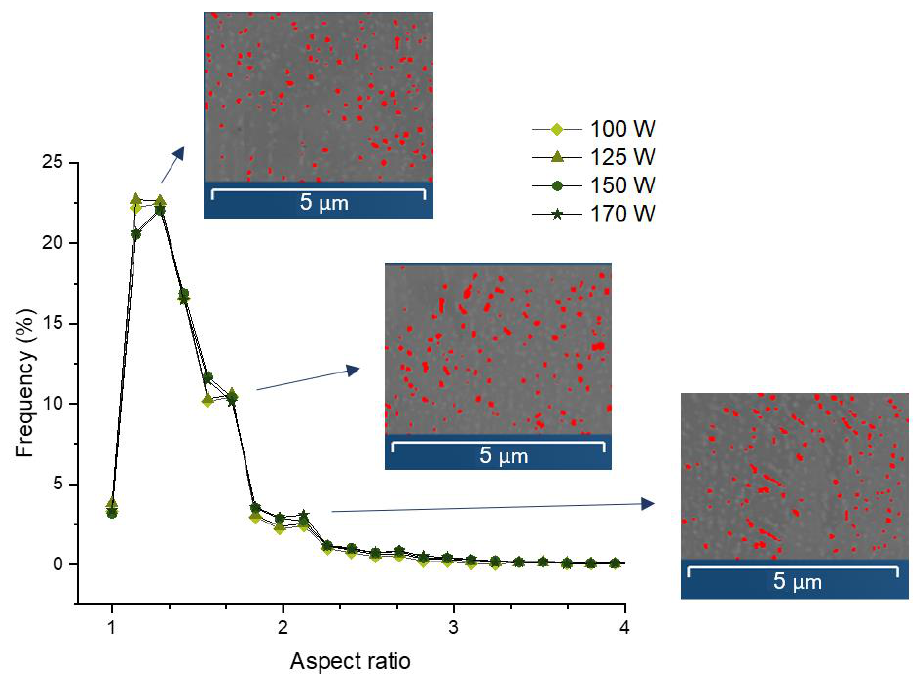
Figure 9. Precipitates aspect ratio distribution and Aztec images for each power condition.